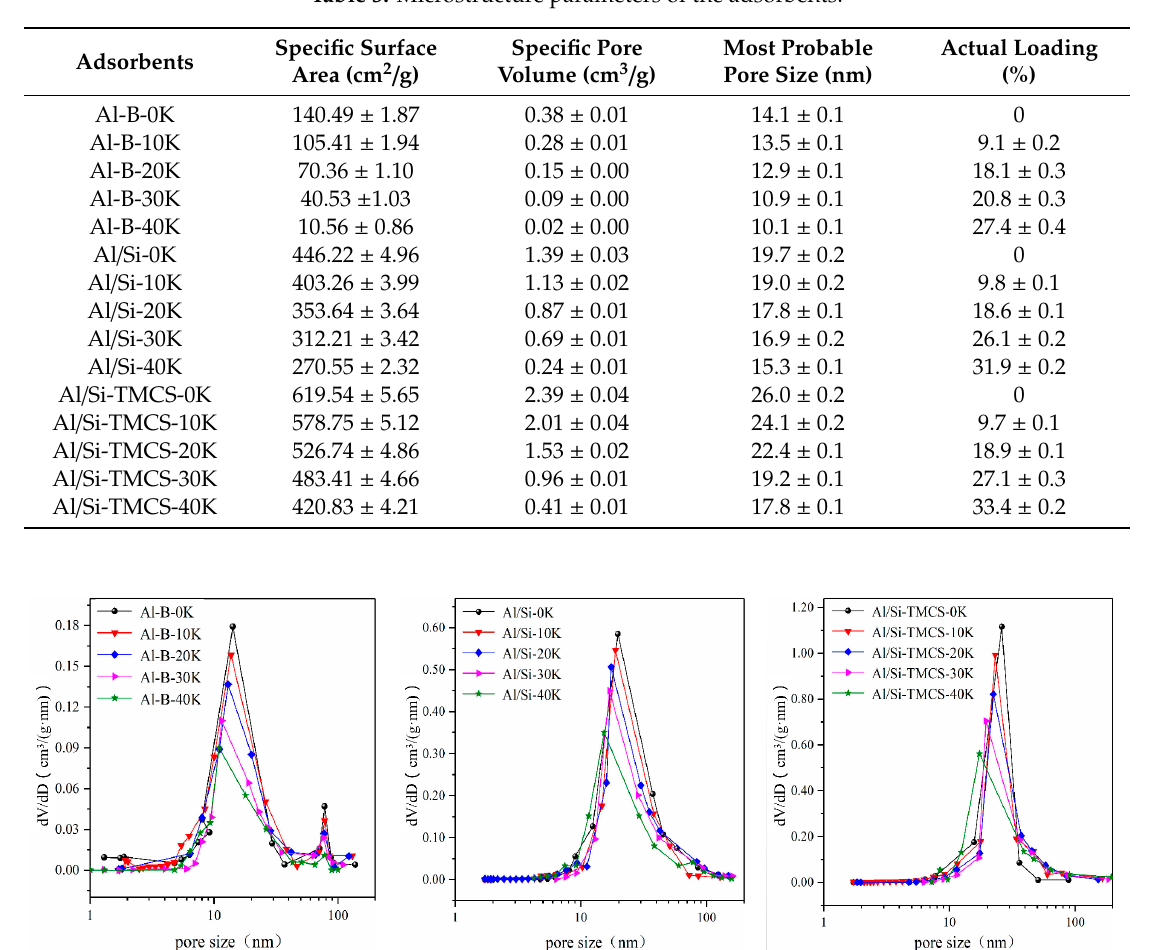
Figure 4. Pore size distribution of the adsorbents after loading.